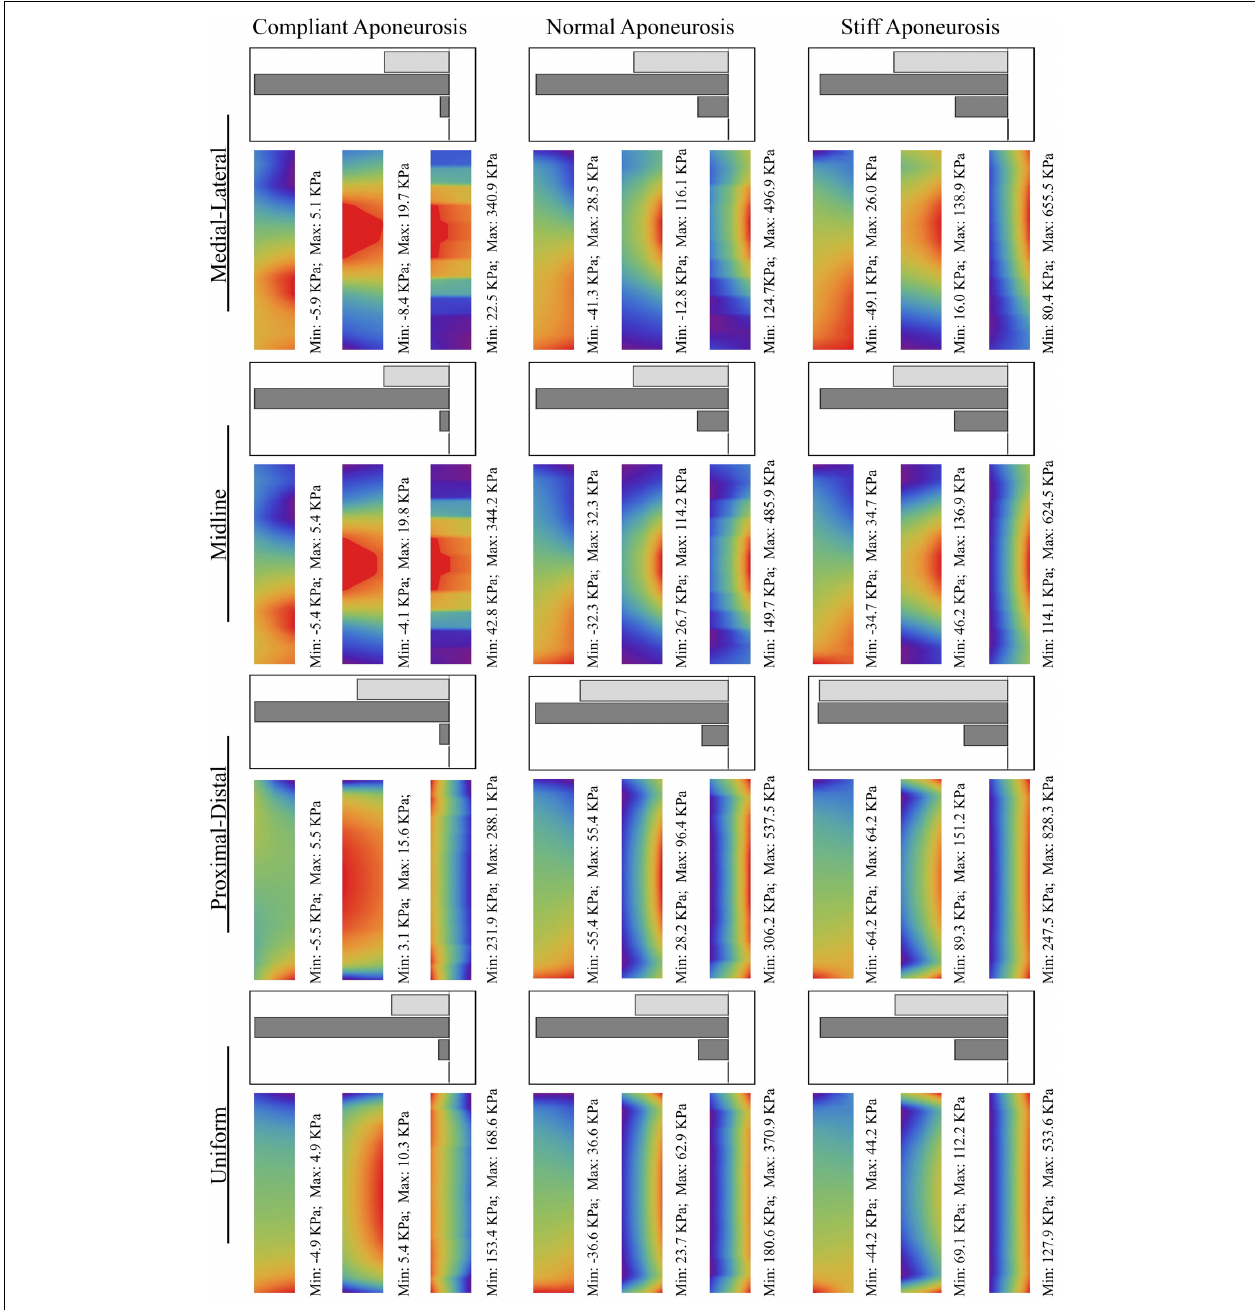
the aponeuroses, and this was balanced by increases in the width of the muscle belly ( Figures 4C,D ) to maintain the incompress- ibility of the muscle tissue. Compressing the muscle belly would cause increases in intramuscular pressure, and this in turn drives increases in the curvature of the muscle fibers (Van Leeuwen and Spoor, 1992). Indeed, in our simulations the initial configurations of the fibers were straight, and this changed to curved S-shapes during contraction. These emergent features of the muscle fibers